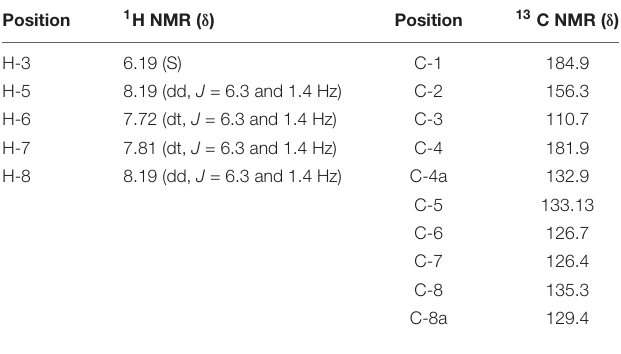
TABLE 3 | 1 H NMR and 13 C NMR data of